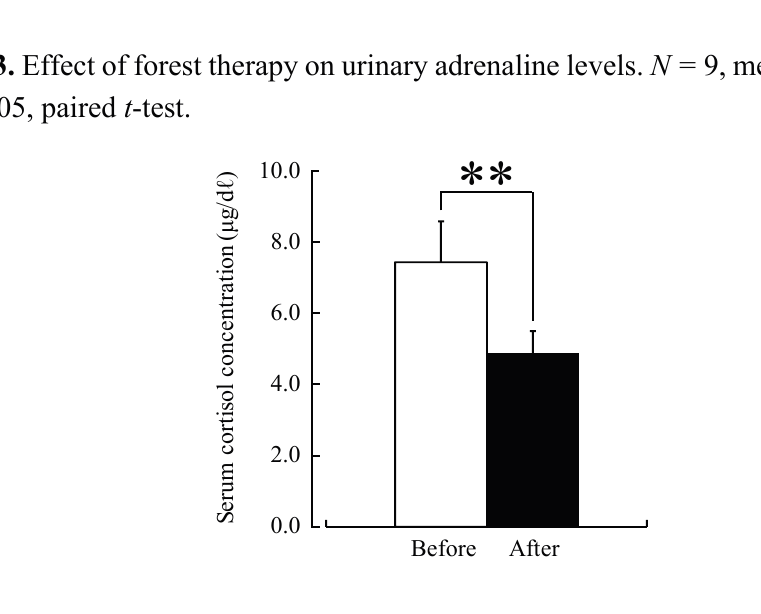
Figure 4. Effect of forest therapy on serum cortisol levels. N = 9, mean ± standard error. ** p < 0.01, paired t